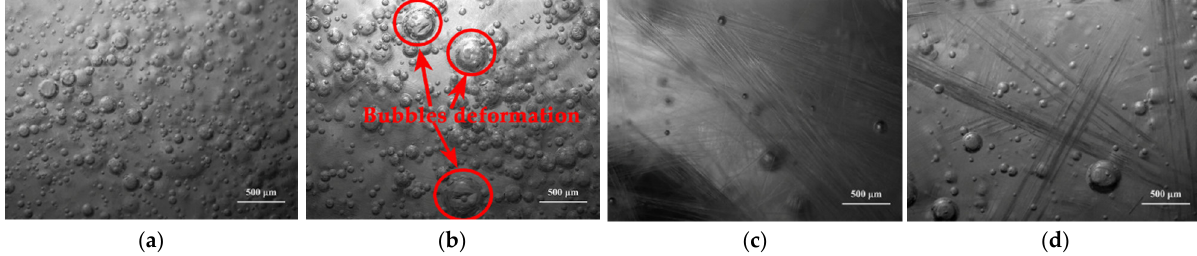
Figure 1. Micrographs of distributions of different kinds of chopped glass fibers, in length of 9.0 mm and with content of 10.00 phr, in resin glue ( a ) in type ECR13-300D-608, ( b ) in type ECR15-600D-608, ( c ) in type ER2400-T628, ( d ) in type ER4800-T718.